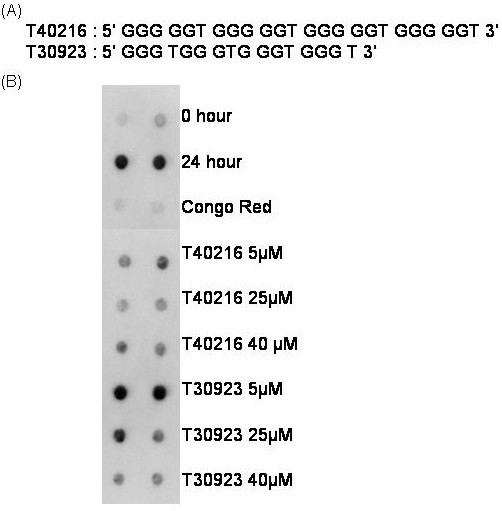
Oligonucleotide inhibition of aggregation of mutant Htt fragment. (A) DNA sequence of two G-rich oligonucleotides that form the G-quartet structure. (B) Dot blot analysis of T40216 and T30923 activity on aggregation. The zero (0) hour control represents reactions that were stopped immediately after addition of the protein; 24-hour reactions carried out in the absence of the oligonucleotide and stopped after 24-hours of incubation; Congo red, level of aggregation 24 hours after addition of Congo Red (10 μM).